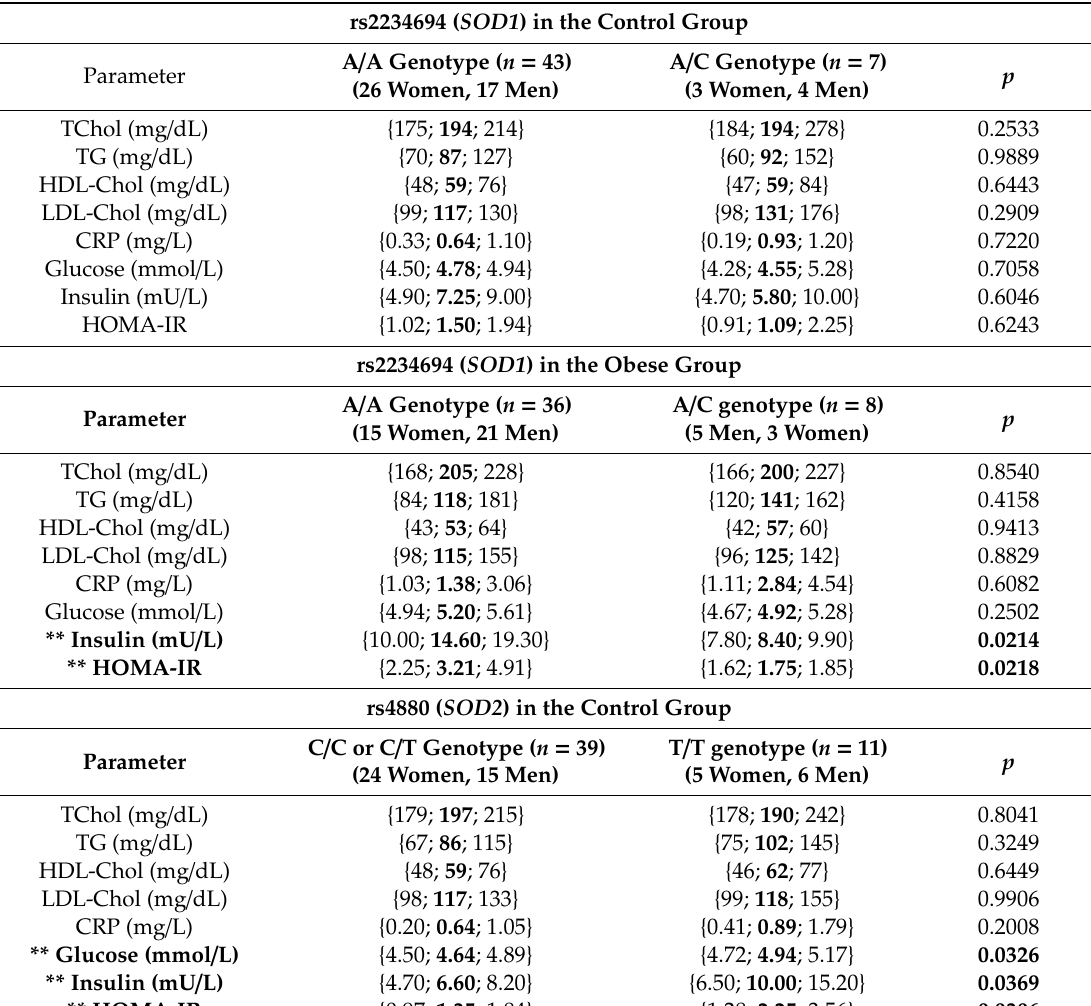
Table A5. Values of selected basic clinical assays: lipidogram, CRP, glucose, insulin concentration and HOMA-IR index, in context of genotypic variability of rs2234694 ( SOD1 ) and rs4880 ( SOD2 ). rs2234694 ( SOD1 ) in the Control